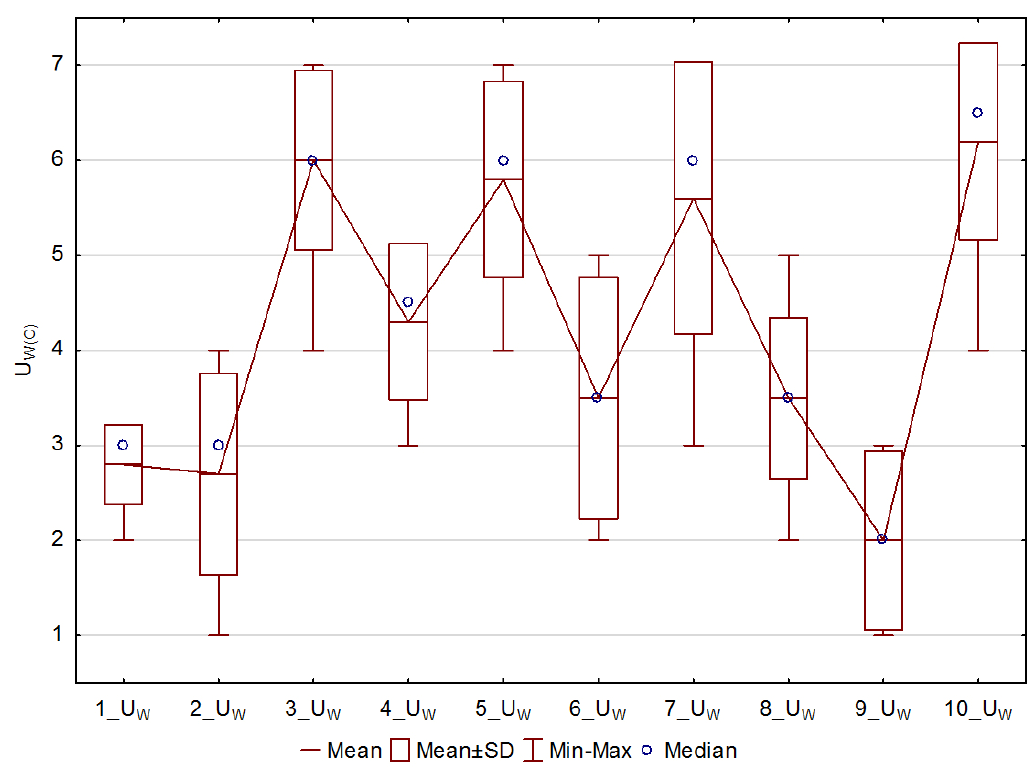
Figure 22. Wall uniformity perception for group C.